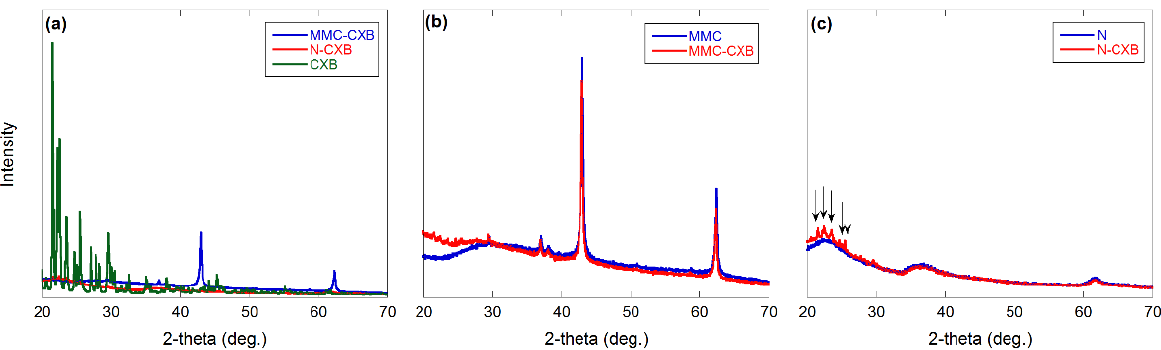
Figure 2. XRD patterns for ( a ) free and loaded CXB and empty and filled ( b ) MMC and ( c ) Neusilin. Differential scanning calorimetry (DSC) results confirm the amorphous state of CXB samples as small endothermic events at 164 ◦ C that correspond to the melting point of CXB. The degree of crystalline CXB present in MMC and Neusilin was calculated to be 0.4 and